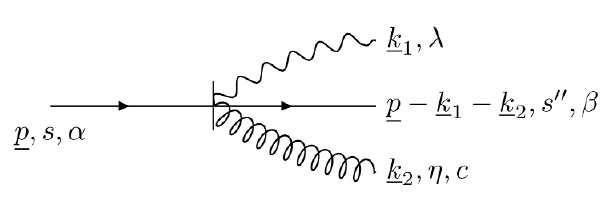
Figure 3 . The instantaneous contribution to the g s g e term in the Fock state of the